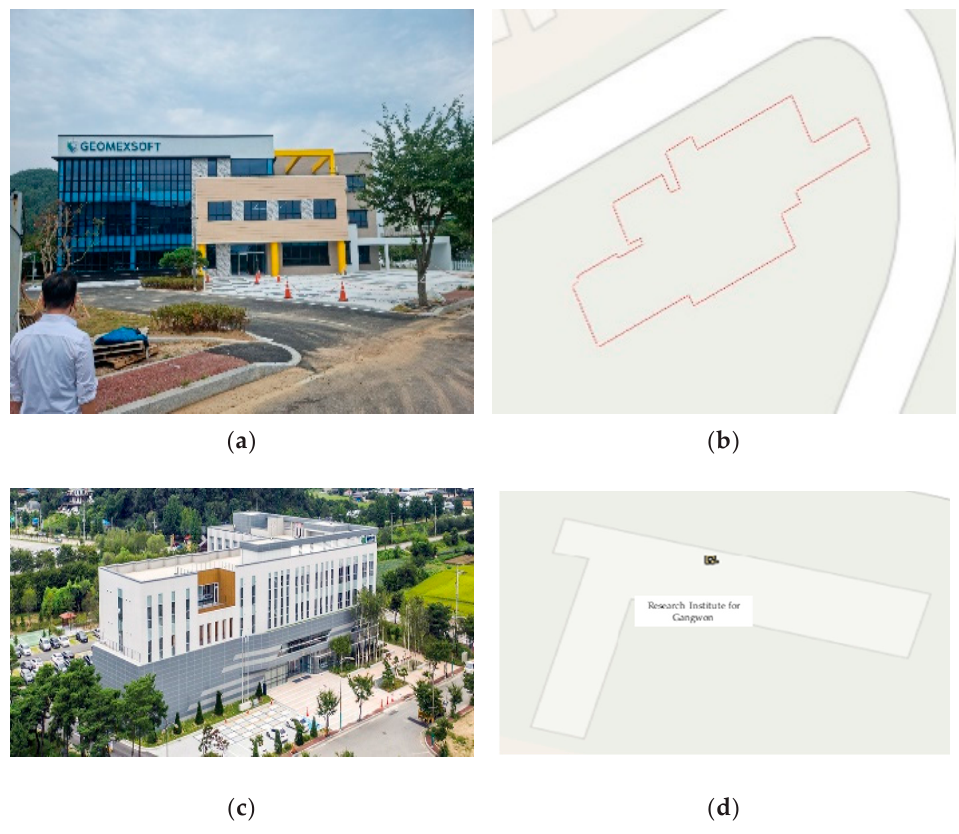
Figure 9. ( a ) Appearance and ( b ) boundary of the Geomexsoft office building. ( c ) Appearance and ( d ) boundary of the Research Institute for Gangwon building.